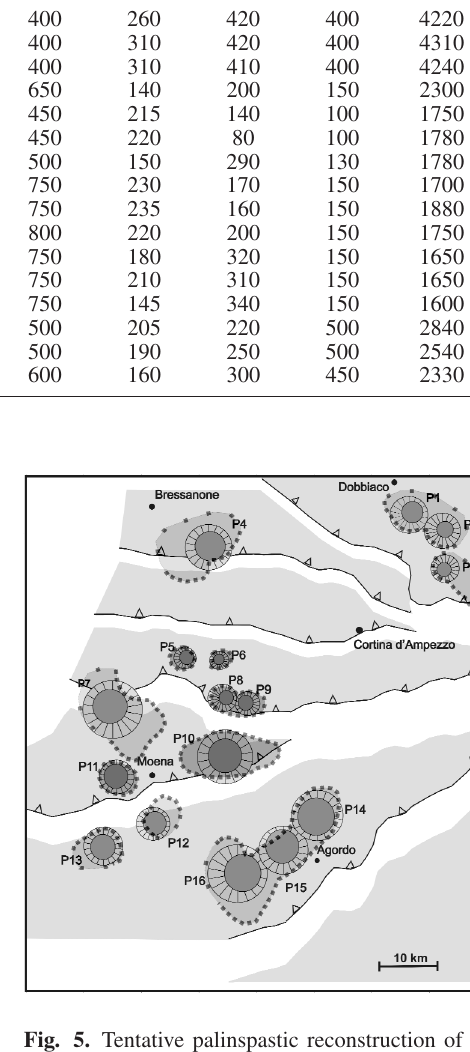
Fig. 5. Tentative palinspastic reconstruction of the Dolomites and assumed location and distribution of the carbonate platforms during Late Anisian-Early Ladinian. Platform labels correspond to table II. The dotted pattern shows the outer limit of the coalesced